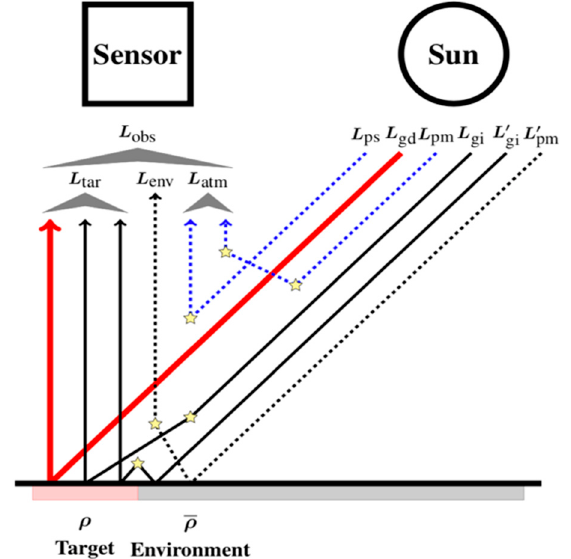
Figure 3 . Radiances observed with a satellite sensor. Figure 3. Radiances observed with a satellite